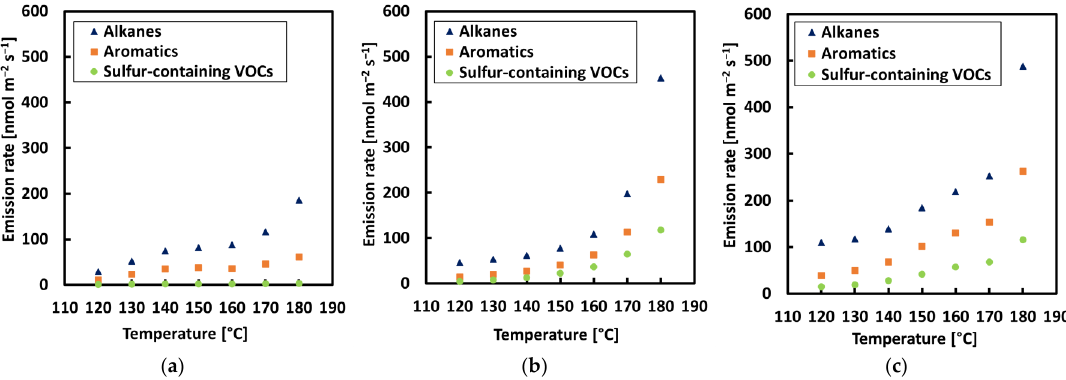
Figure 5. VOC concentration rate of alkanes, aromatics, and sulfur compounds for each sample with an incremental increase in temperature: ( a ) REF, ( b ) CRMB1, and ( c ) CRMB2.